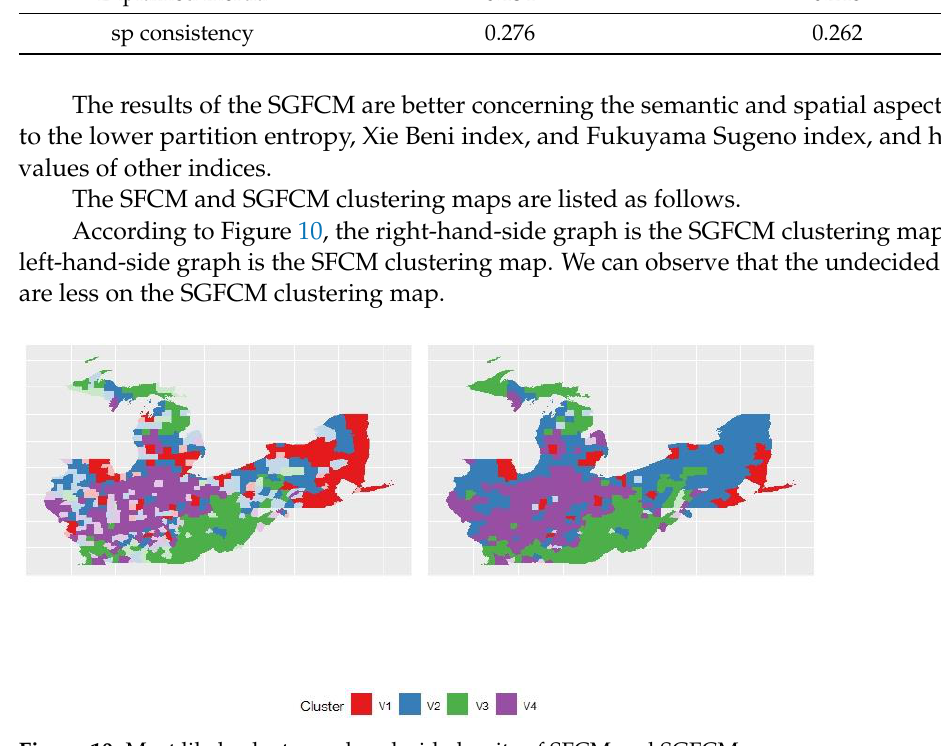
Figure 10. Most likely cluster and undecided units of SFCM and SGFCM.